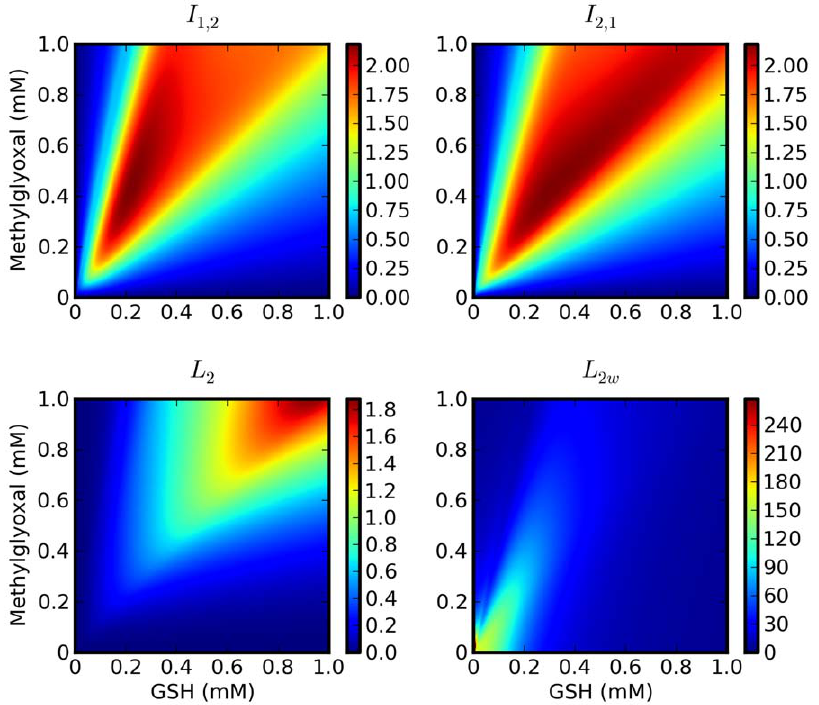
Figure 5. Landscapes of different measures of model divergences in the allowed optimization range of concentrations of pathway substrates. Measures of model distances are I 1,2 : extended Kullback-Leibler distance of model 2 from model 1 (equation 6). I 2,1 : extended Kullback- Leibler distance of model 1 from model 2 (equation 6). L 2 : simple L 2 norm (equation 4). L 2 w : weighted L 2 norm (equation 5).